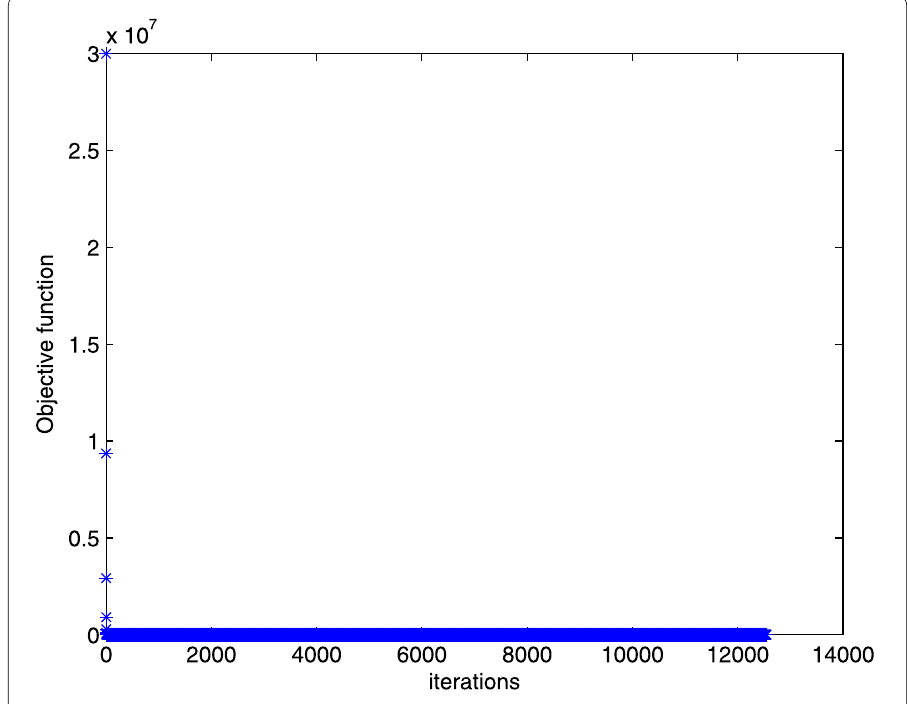
Figure 7 Numerical results for solving Example 4 with Algorithm 1